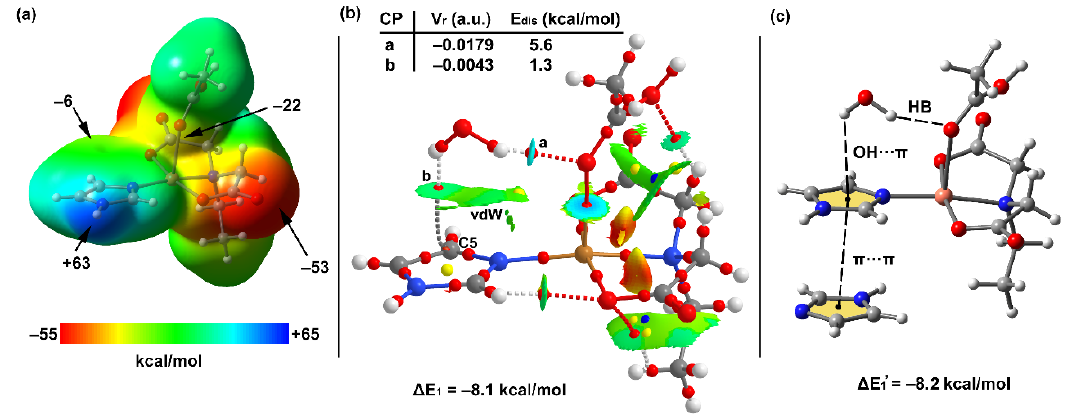
Figure 10. ( a ) MEP surface (isosurface 0.001 a.u.) of model A at the PBE0-D3/def2-TZVP level of theory. Values at selected points of the surfaces given in kcal/mol. ( b ) Combined QTAIM/NCIplot analysis of the complex between model A and water. Bond and ring critical points represented as red and ring spheres, respectively. For the NCIplot isosurface (0.5 a.u.), the –0.04 < sign( λ 2 ) ρ < 0.04 color scale was used. Gradient cut-off = 0.04 a.u. ( c ) Trimer used to evaluate the influence of the π -stacking on the OH··· π interaction.